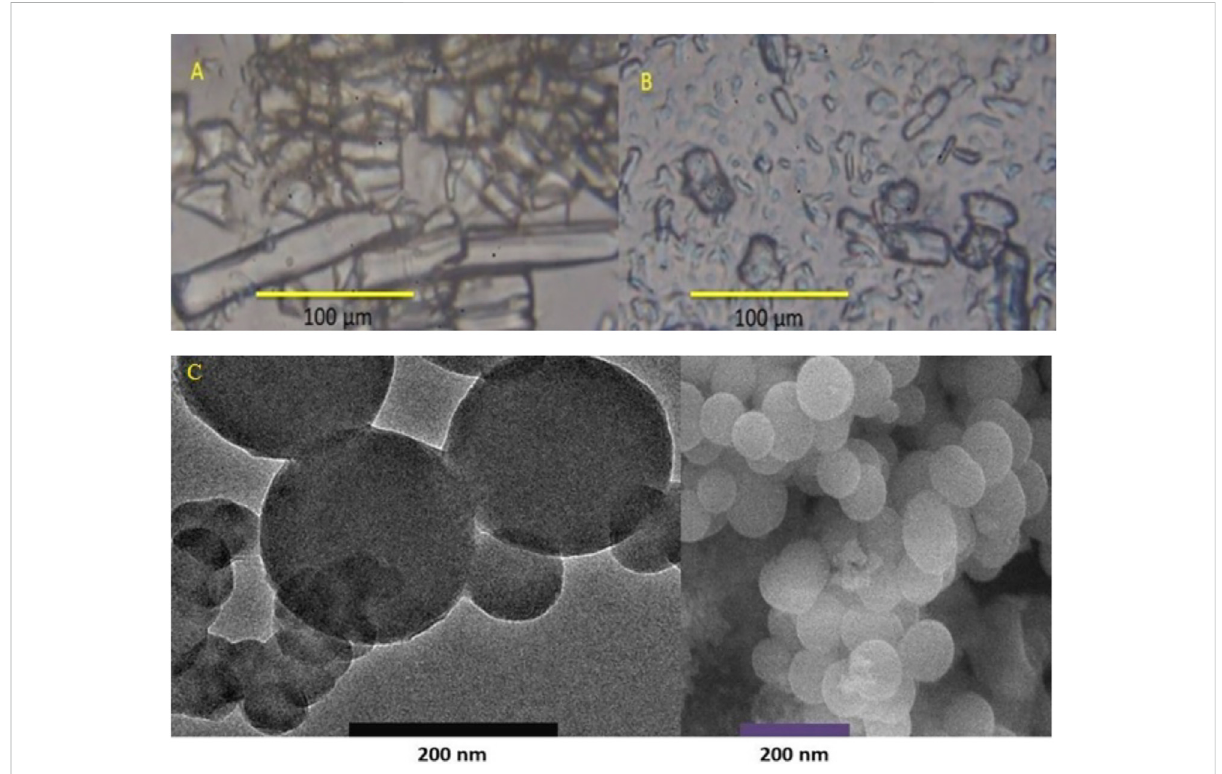
FIGURE 4 (A,B) Bright- fi eld microscopy images of API (A) and commercial nasal spray (B) . (C) . TEM and SEM images of MSN-MF.